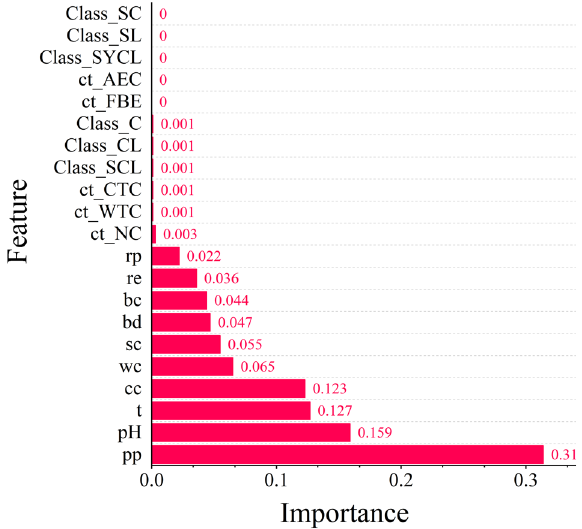
Fig. 3 The relative importance of 21 features according to AdaBoost. The important features will be used for the subsequent optimization step.